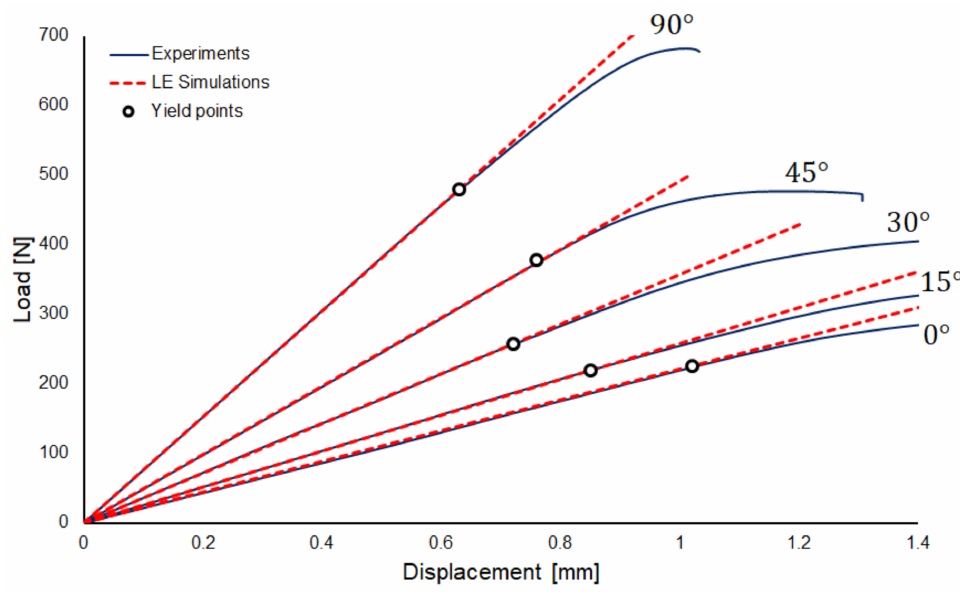
Figure 5. Experimental results and linear elastic simulations.